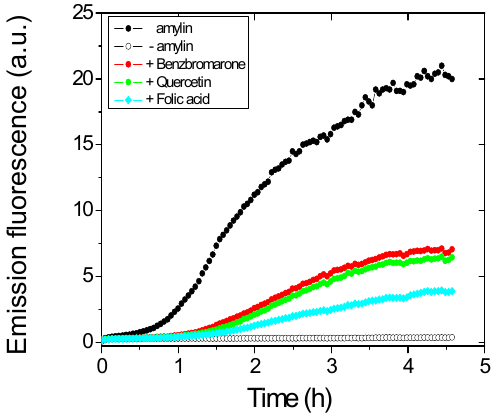
Figure 1. Inhibition of amylin (8–37) aggregation by benzbromarone, quercetin, and folic acid, followed by an increase in Thioflavin T (ThT) emission fluorescence at 482 nm. Black dots: positive aggregation control, only amylin; white dots: negative aggregation control (no amylin); Red, green, and cyan dots: aggregation of amylin in presence of benzbromarone, quercetin, and folic acid, respectively.